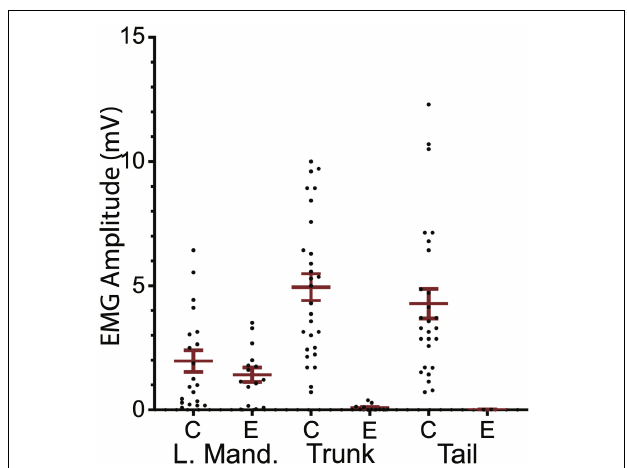
FIGURE 7 | Comparison of control and experimental EMG responses elicited by M-axon activation. Comparisons of control (C) and experimental (E) EMG responses of left mandibular muscle (L.Mand.) and trunk and tail musculature. Left mandibular control and experimental EMG amplitudes (mean ± S.E.M.) were not significantly different ( P = 0.50) while the control trunk and tail EMGs were significantly greater ( P < 0.001) than those of experimental fish.